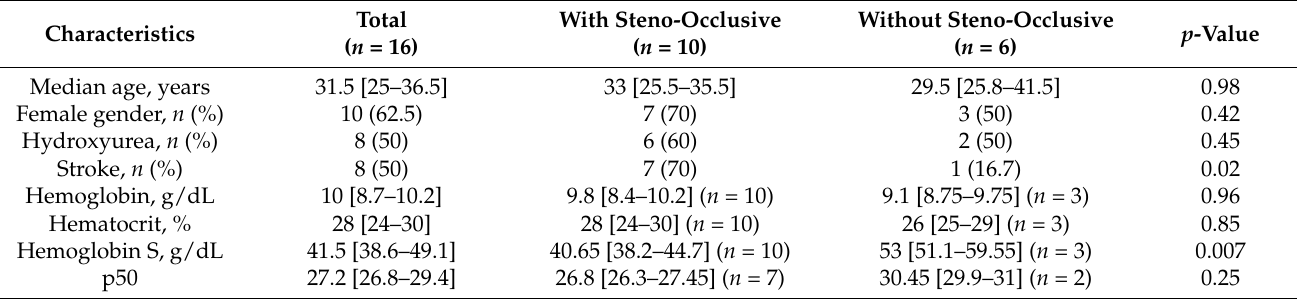
Table 1. Main clinical and biological variables from patients with SCD in two subgroups according to their cerebral steno-occlusive arterial disease